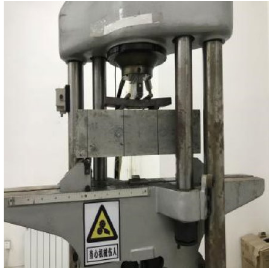
Figure 5. Loading device for four-point flexure test of concrete.